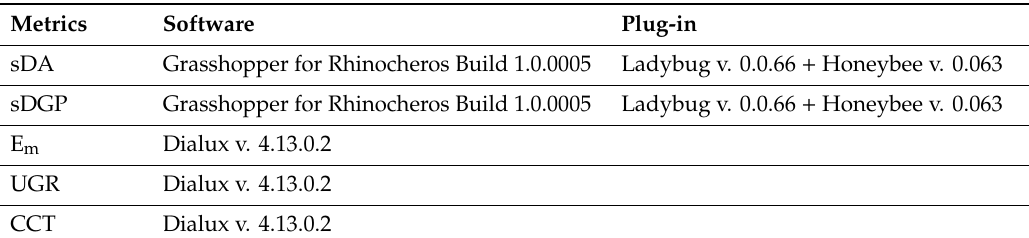
Table 5. Software used in the